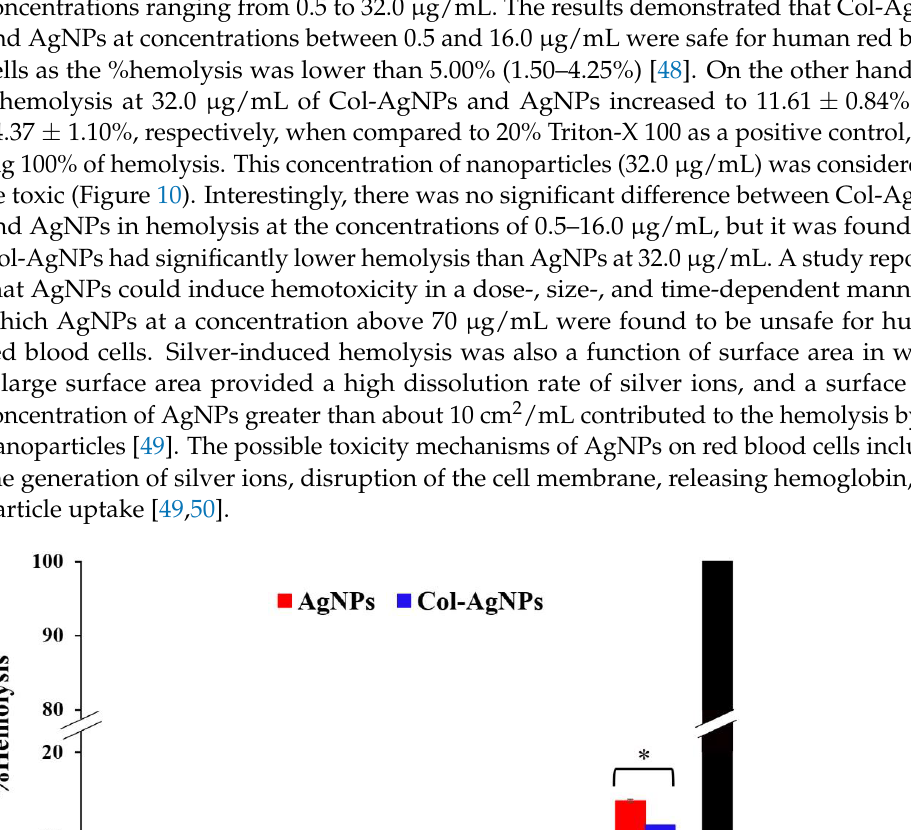
Figure 9. Proposed mechanism of Col - AgNPs against Gram - negative bacteria .